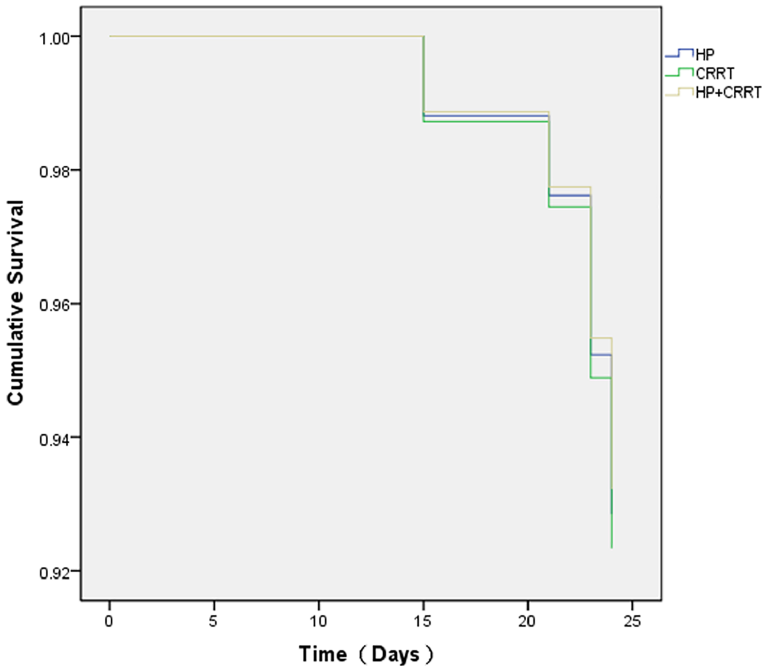
Fig 2. Comparison of survival curves for three treatments. Hemoperfusion(HP), continuous renal replacement therapy (CRRT), and combinedtreatment (HP+CRRT) in patients with plasma paraquat levels between50 and 1,000 ng/mL. The chi-squaredvalue betweenHP and CRRT was 1.056; p > 0.05.The chi- squaredvalue betweenHP and HP+CRRT was 1.136; p >